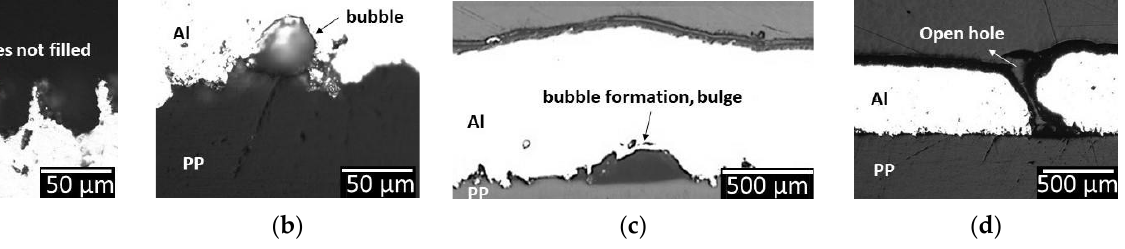
Figure 13. Different cross sections of defects: hole ( a ); bubble ( b ); lack of wettability or unreachable cavities ( c ); and an open hole in Al due to excessive thermal decomposition of PP ( d ). By increasing the modulated power to 290 and 300 W, the first indications of PP